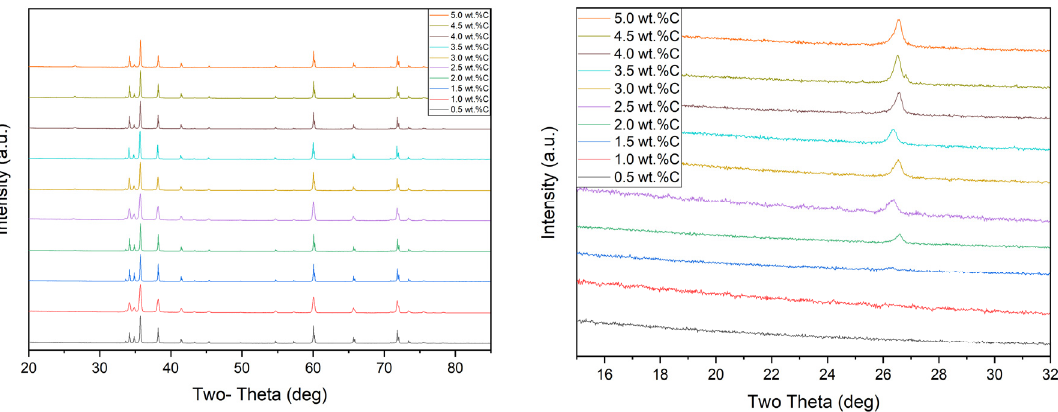
Figure 4. The phase identification of the XRD patterns of wet mixed SiC with di ff erent amounts of carbon addition ( left ), an enlarged view (2 θ = 15 ◦ to 32 ◦ ) of X-ray di ff raction patterns of wet mixed SiC ( right